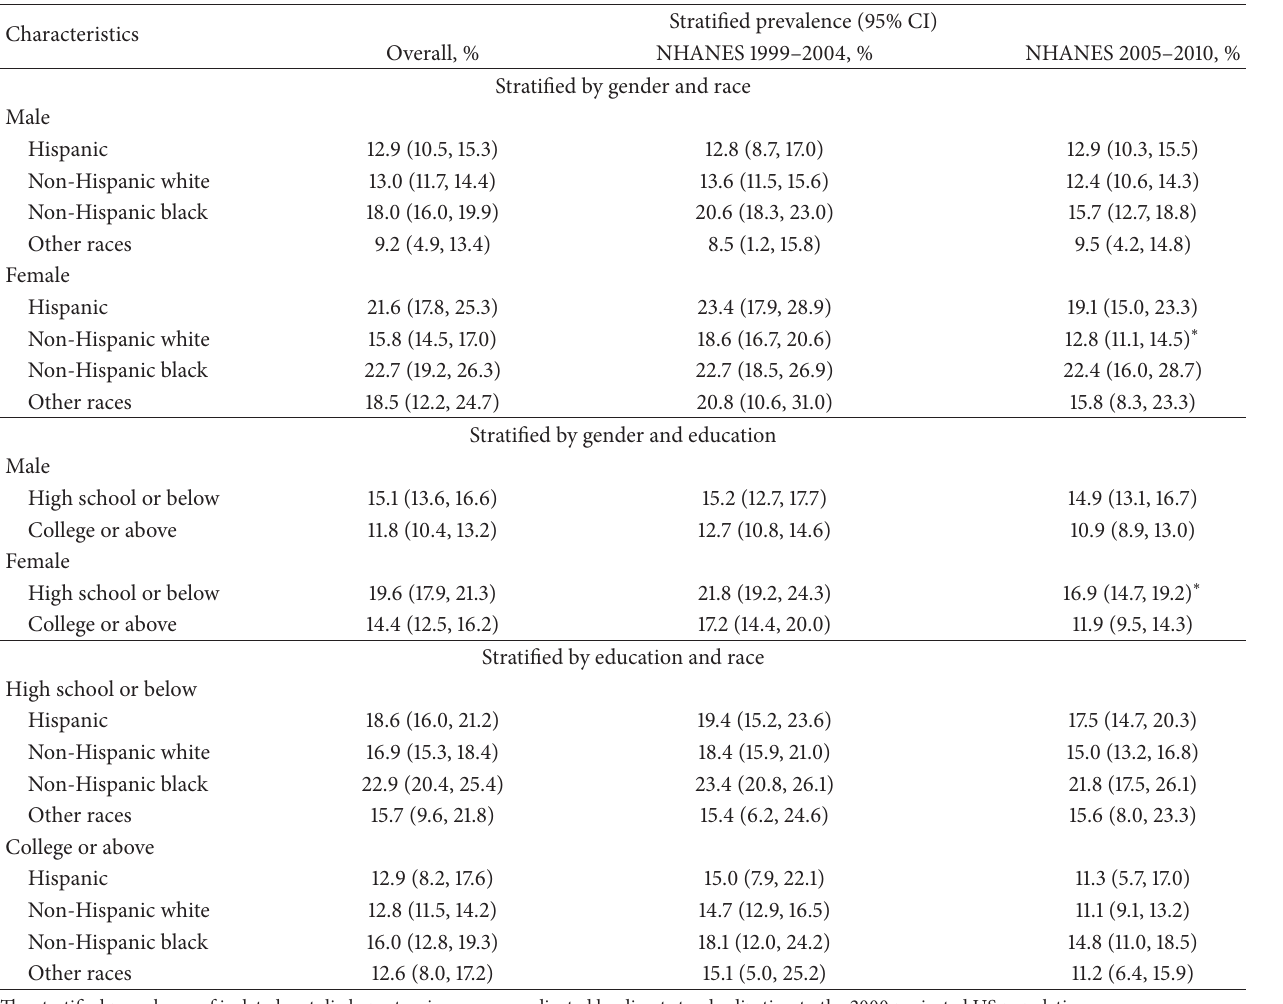
Table 3: Prevalence and changes of untreated isolated systolic hypertension stratified by characteristics in NHANES 1999–2010,